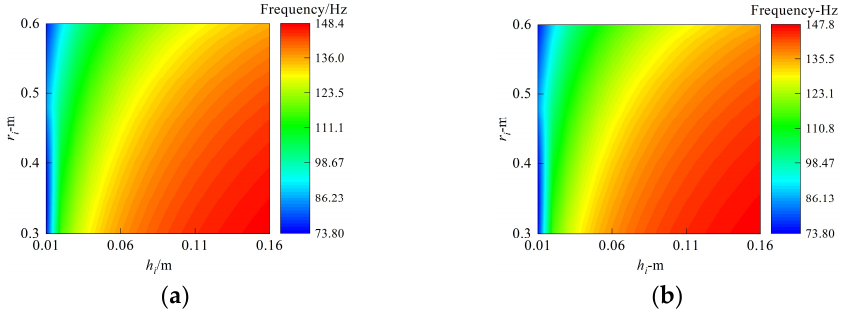
Figure 8. Comprehensive influence of thickness and inner diameter of annular plates. ( a ) Clamped boundary. ( b ) Free boundary.